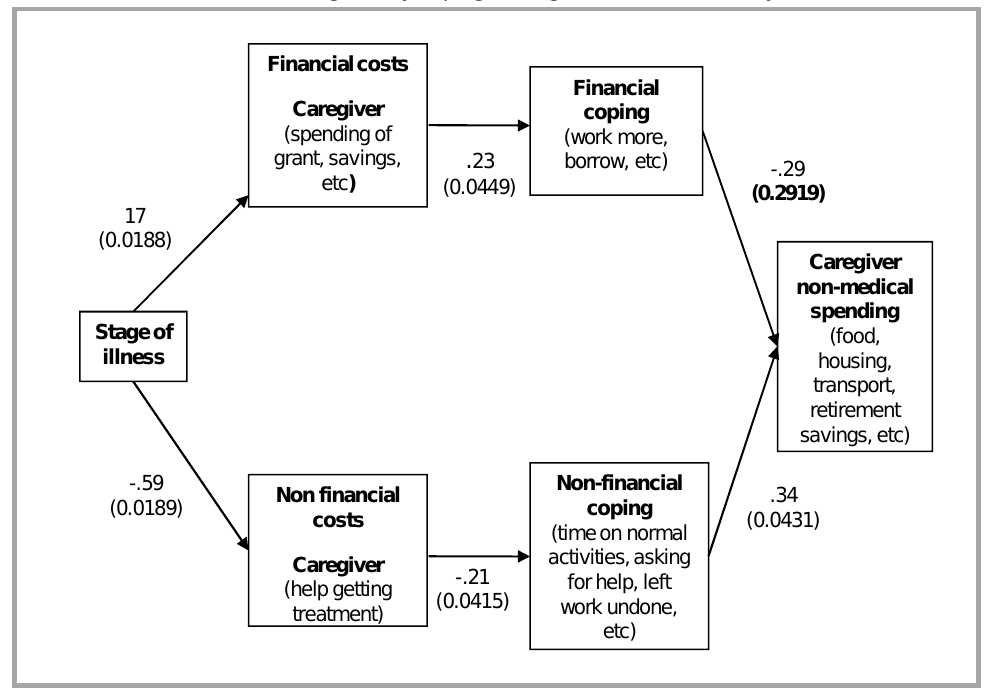
The resulting elderly coping strategies found in this